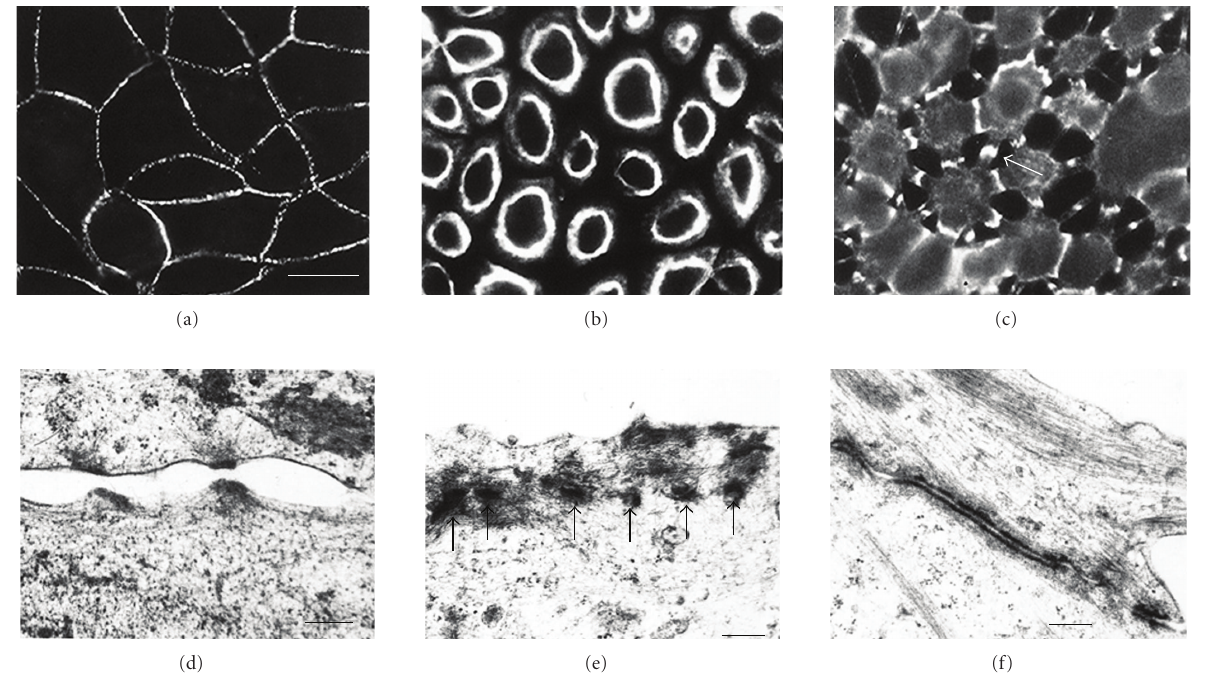
Figure 3: Desmosomes of MDCK cells can be calcium-dependent or calcium-independent. (a) Desmosomes of MDCK cells in confluent culture stained with monoclonal antibody to desmoplakin. Note that the desmosomes are located at the cell peripheries and that the staining is generally punctate. (b) A monolayer that has been cultured at confluent density for 24 hours in SM and then treated with LCM-EGTA for 90 minutes, showing loss of intercellular contact and of desmosomal staining from the cell peripheries. This is indicative of calcium- dependent desmosomes. (c) A 6-day-confluent monolayer treated with LCM-EGTA for 90 minutes, showing partial loss of intercellular contact but persistence of joining processes with intense desmosomal staining (e.g., arrow). This is indicative of calcium-desmosomes. Bar, 20m. (d) When subconfluent or 1-day-confluent cells are treated with LCM-EGTA adhesion is lost and desmosomal halves separate. The